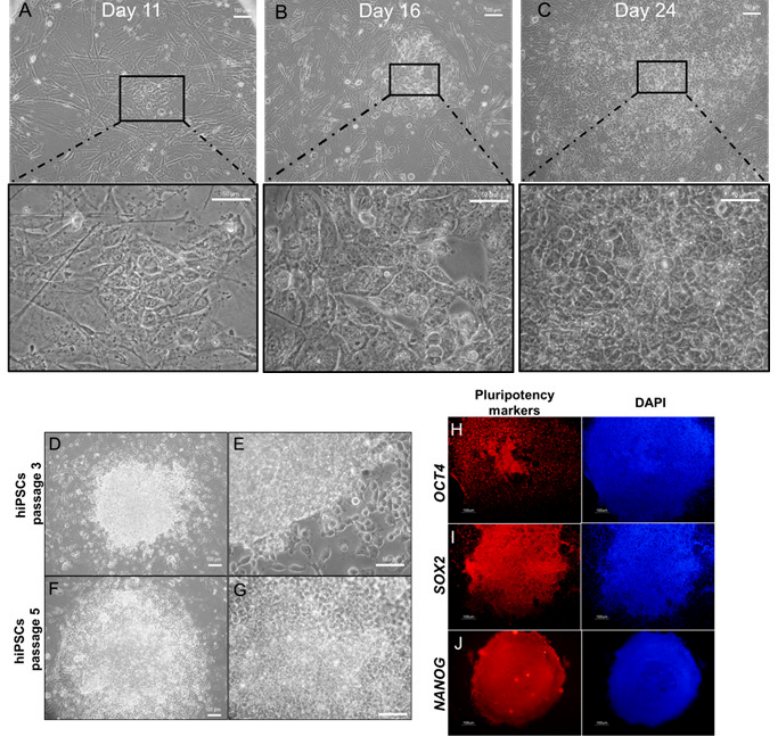
Figure 2. Induction of hiPSC-like colonies by episomal vectors containing the Yamanaka factors and detection of pluripotency markers in the reprogramed cells. The emergence of hiPSC-like colonies was monitored at day 11 ( A ), 16 ( B ), and 24 ( C ). Each day corresponds to a different colony. Representative images for the expansion and maintenance of hiPSC-like colonies at passage 3 ( D ) and 5 ( F ). Representative high magnification images of a hiPSC-like colony on passage 3 ( E ) and 5 ( G ). Detection of the OCT4 ( H ), SOX2 (I), and NANOG ( J ) protein by immunofluorescence on hiPSC-like colonies at passage 5 counterstained with DAPI. Scale bars represent 100 µ m for A–G and 50 µ m for